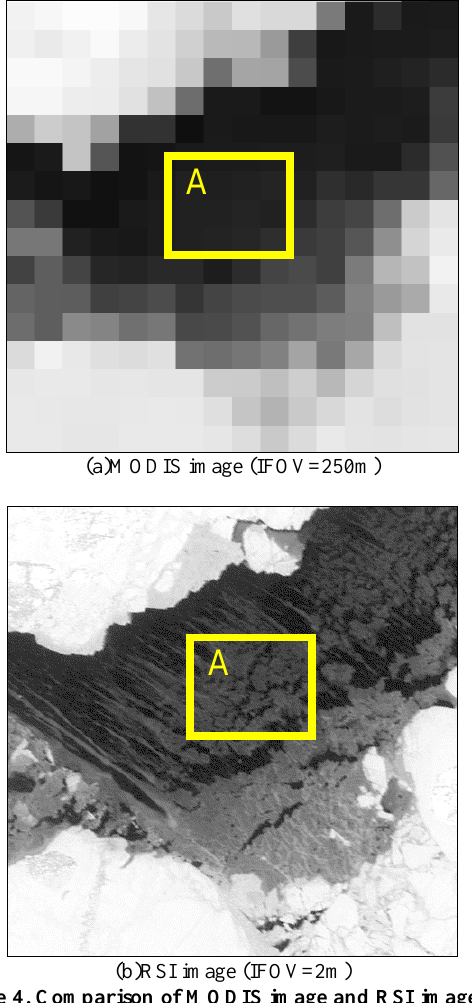
Figure 5. Binarization of MODIS data and Ice concentration (IC) image derived from MODIS data.